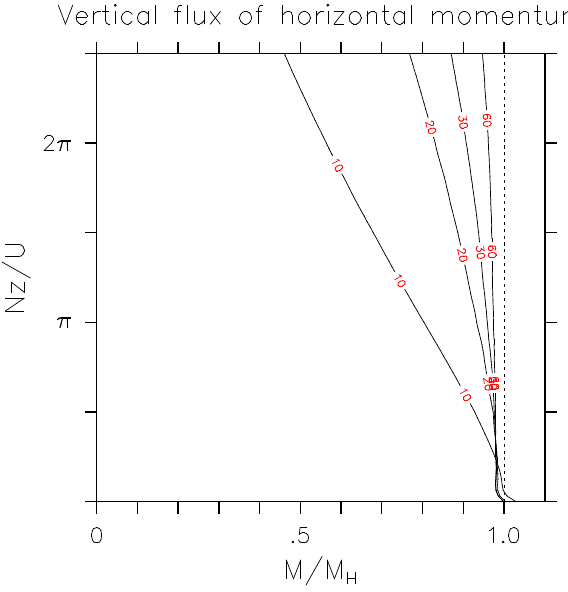
Figure 3. Vertical flux of horizontal momentum, normalized by its FIG. 3. Vertical flux of horizontal momentum, normalized by its analytic value at several 2 analytic value at several nondimensional times ¯ ut ut . M and M H are the momentum flux of the numerical and analytic 3 nondimensional times the momentum flux of the numerical and analytic a solutions. 4